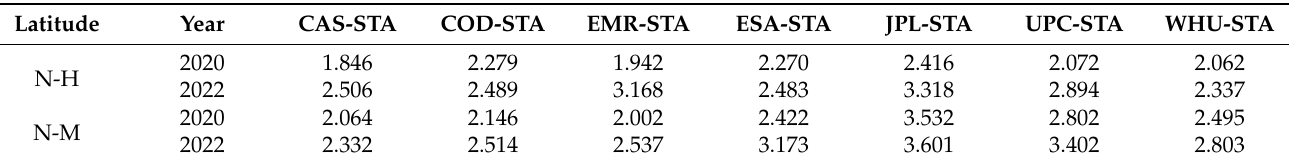
Figure 11. Global distribution of mean RMS for different GIM products with measured VTEC values in 2022. Table 6. RMS values of different GIMs with GNSS monitoring stations using VTEC in different latitude bands, in the units of TECu.